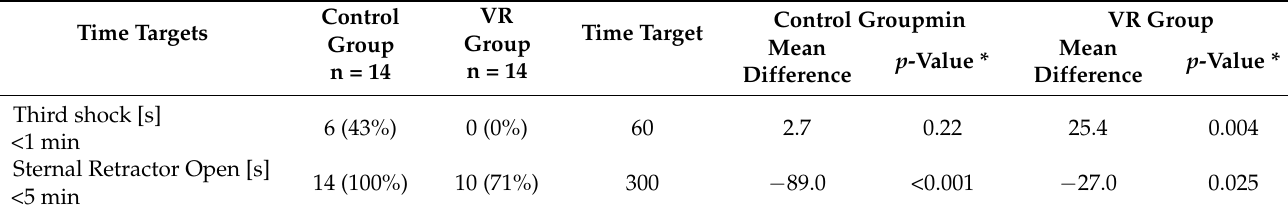
Table 2. Table showing the proportion of participants from each group that achieved the time targets for the Cardiac Surgery Unit Advanced Life Support (CSU-ALS) protocol, in addition to statistical comparison to the time target using a one-sample t -test. Data are presented as mean ± SD or median (IQR).